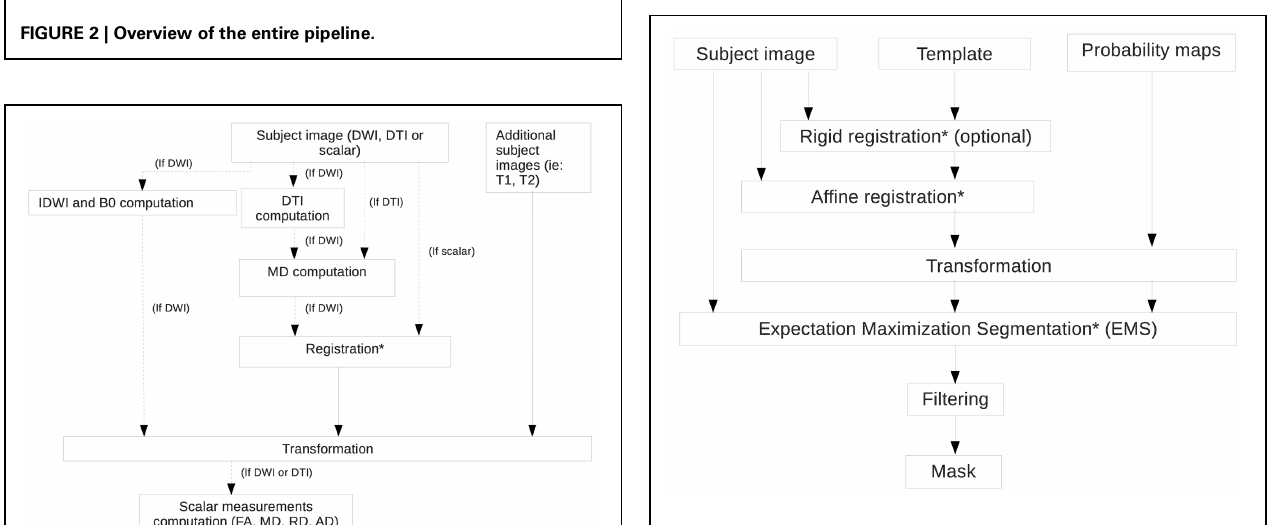
FIGURE 4 | Skull-stripping pipeline. Registrations are performed using RegisterImages and Expectation Maximization Segmentation (EMS) is computed with Atlas Based Classification (ABC). Both tools are available in 3D